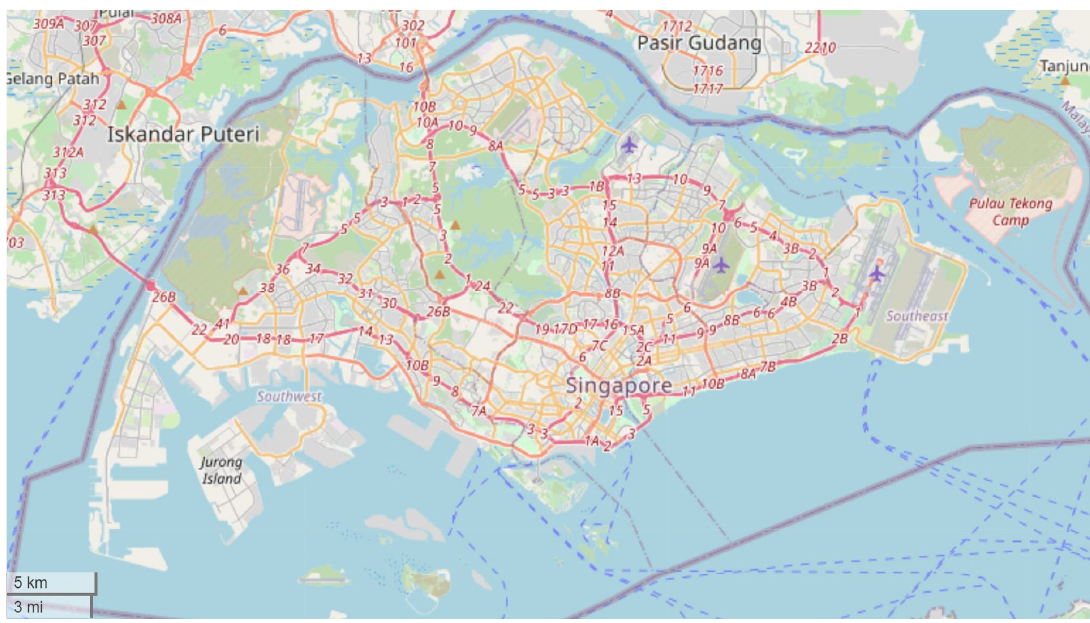
Figure 1. Map of study setting. Source: https: // www.openstreetmap.org / #map = 11 / 1.3680 /